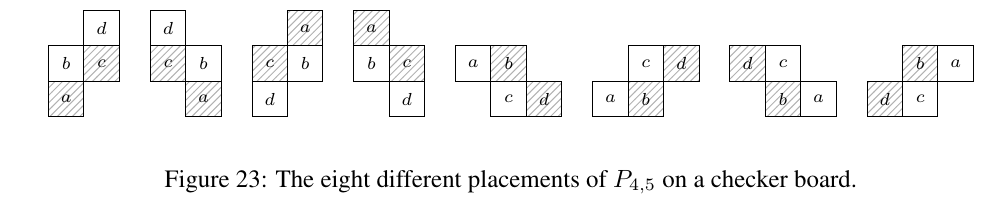
Figure 22: (a) A (2 , 4) history dependent priority breaker strategy for P 4 , 5 . The priorities depend on the parity of the current maker mark. Even cells are shaded. (b) The goal cells { a, b, c, d } and the considered history cells { h 1 , . . . , h 5 } .